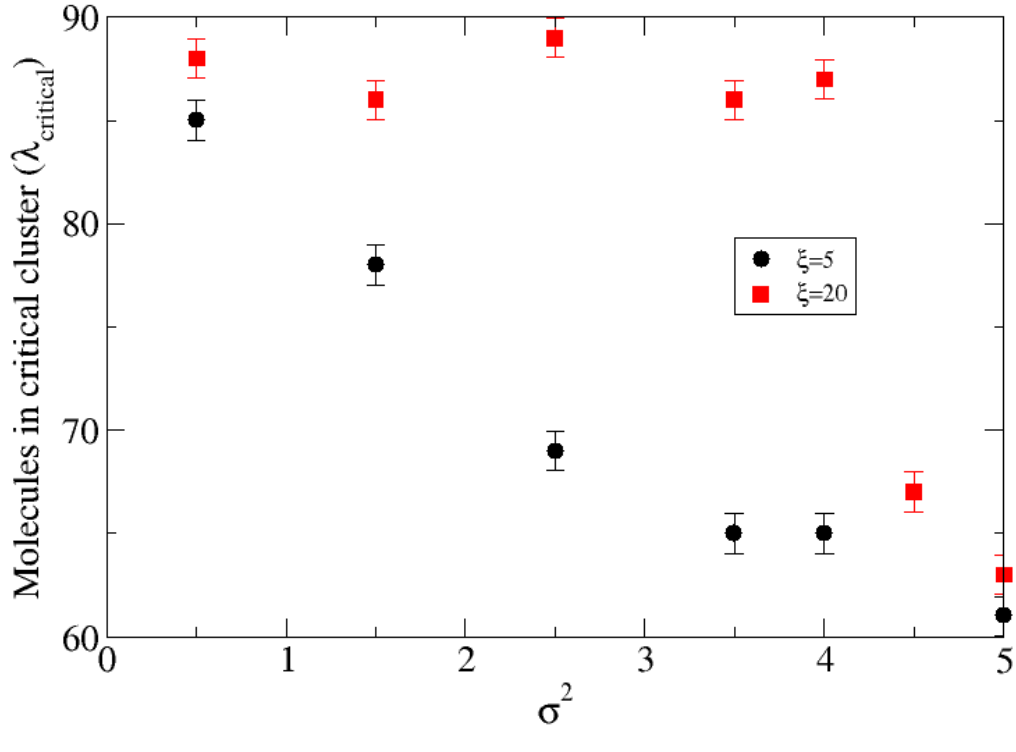
Figure 2. Rate of formation of clusters (vertical axis, in units of ν − 1 with zero or slightly attractive interactions ( (cid:101) w = 0 and (cid:101) w = 0.1) having variance σ 2 = 2.5 and 5.0. The curves are indistinguishable.